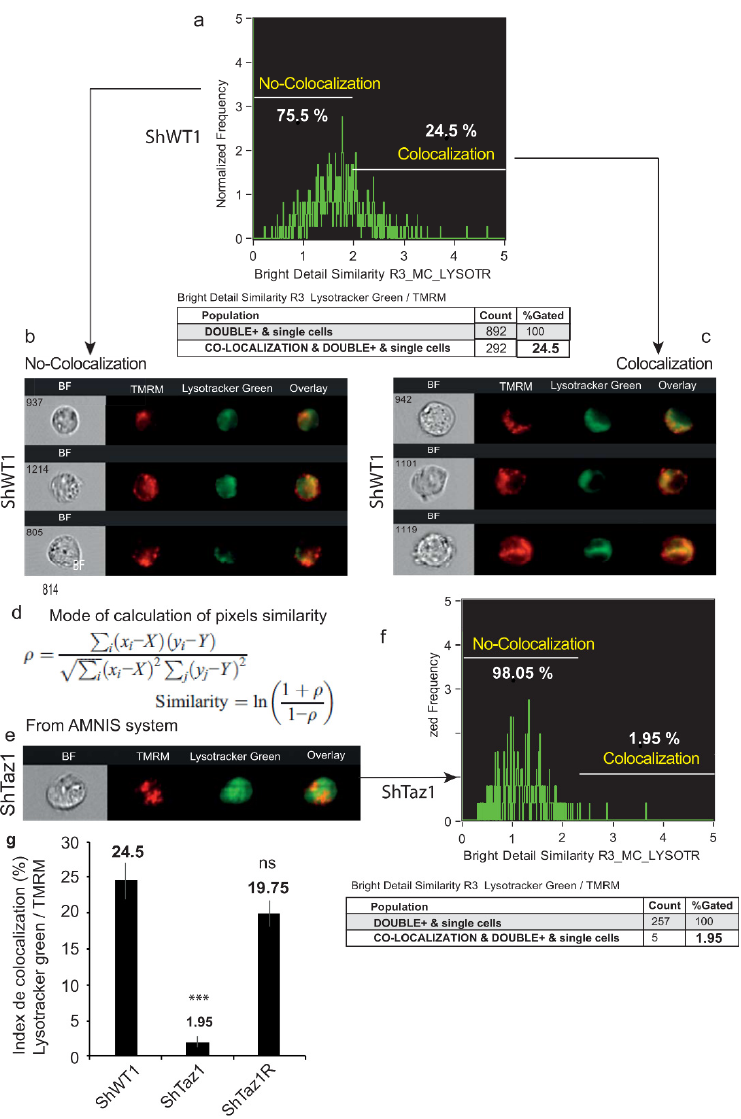
Figure 8. Image analysis of the co-localization of LysoTracker Green (lysosomes and acidic fusion vesicles) and the mitochondrial membrane potential dye, TMRM. ( a ) Colocalization based on brightness similarity and the corresponding histogram with 75.5% of the cells exhibiting different similarity indices, whereas 24.5% exhibit strict co-localization estimated by the similarity index. ( b ) Images of cells with similarity index < 2; no co-localization of the two probes. ( c ) Images of cells with similarity index > 2, which indicates co-localization of mitochondria in the acidic vesicles. ( d ) Method of calculation used to estimate the similarity index. ( e , f ) Analysis of ShTaz1 cells, which are deficient in tafazzin; ( e ) images and ( f ) curve of co-localization. ( g ) The co-localization index is reported on a histogram for the three cell types (ShWT1, ShTaz1, and ShTaz1R). ± SEM on 5 di ff erent preparations. ns = no significant and *** is the p -value ≤